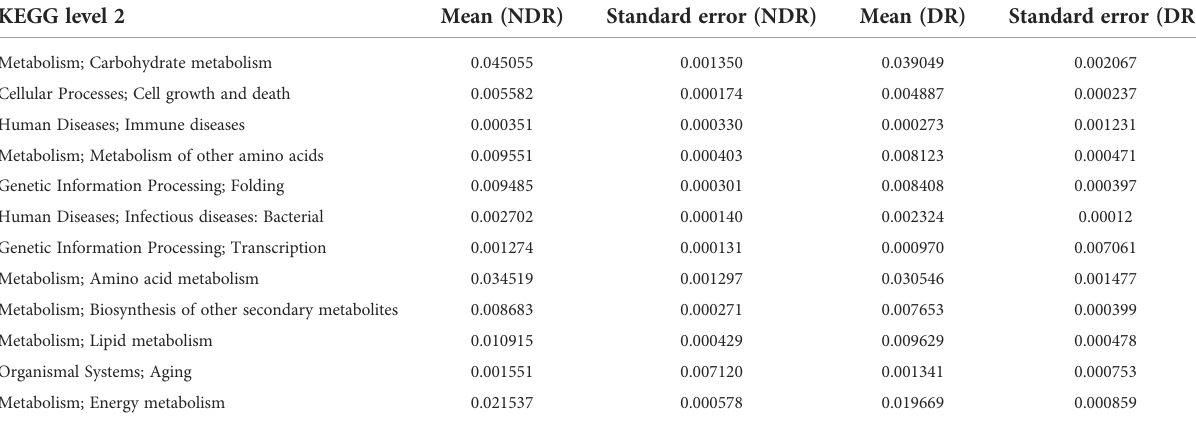
TABLE 2 Metastat of the functional differences between the groups. KEGG level 2